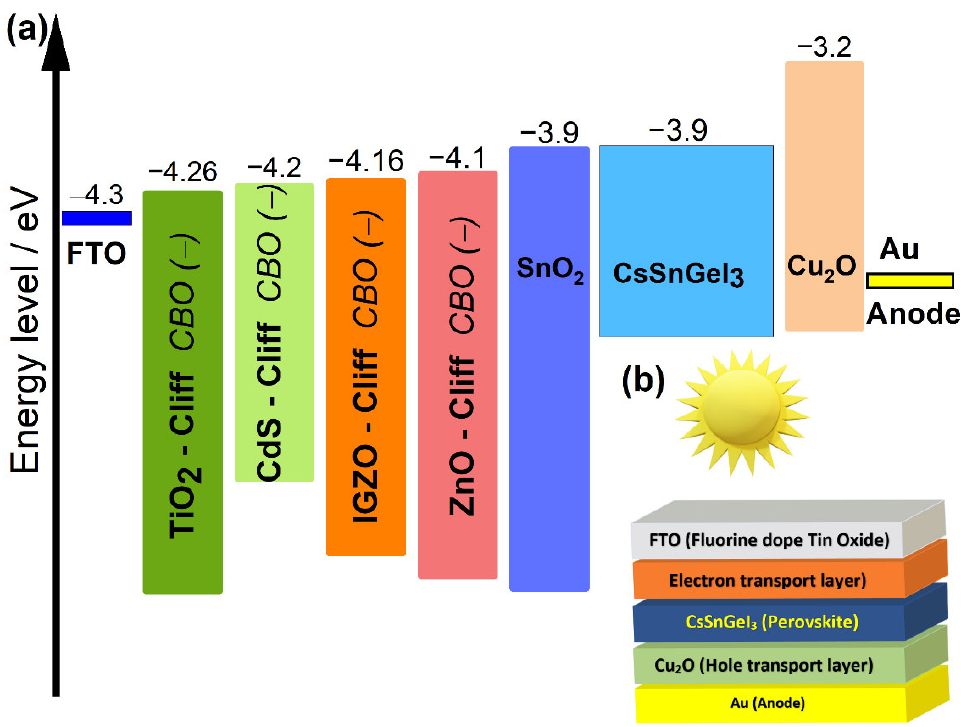
Figure 1. ( a ) Band alignment between ETL materials and CsSnGeI 3 perovskite. ( b ) Schematic diagram of lead-free CsSnGeI 3 -based PSC structure.